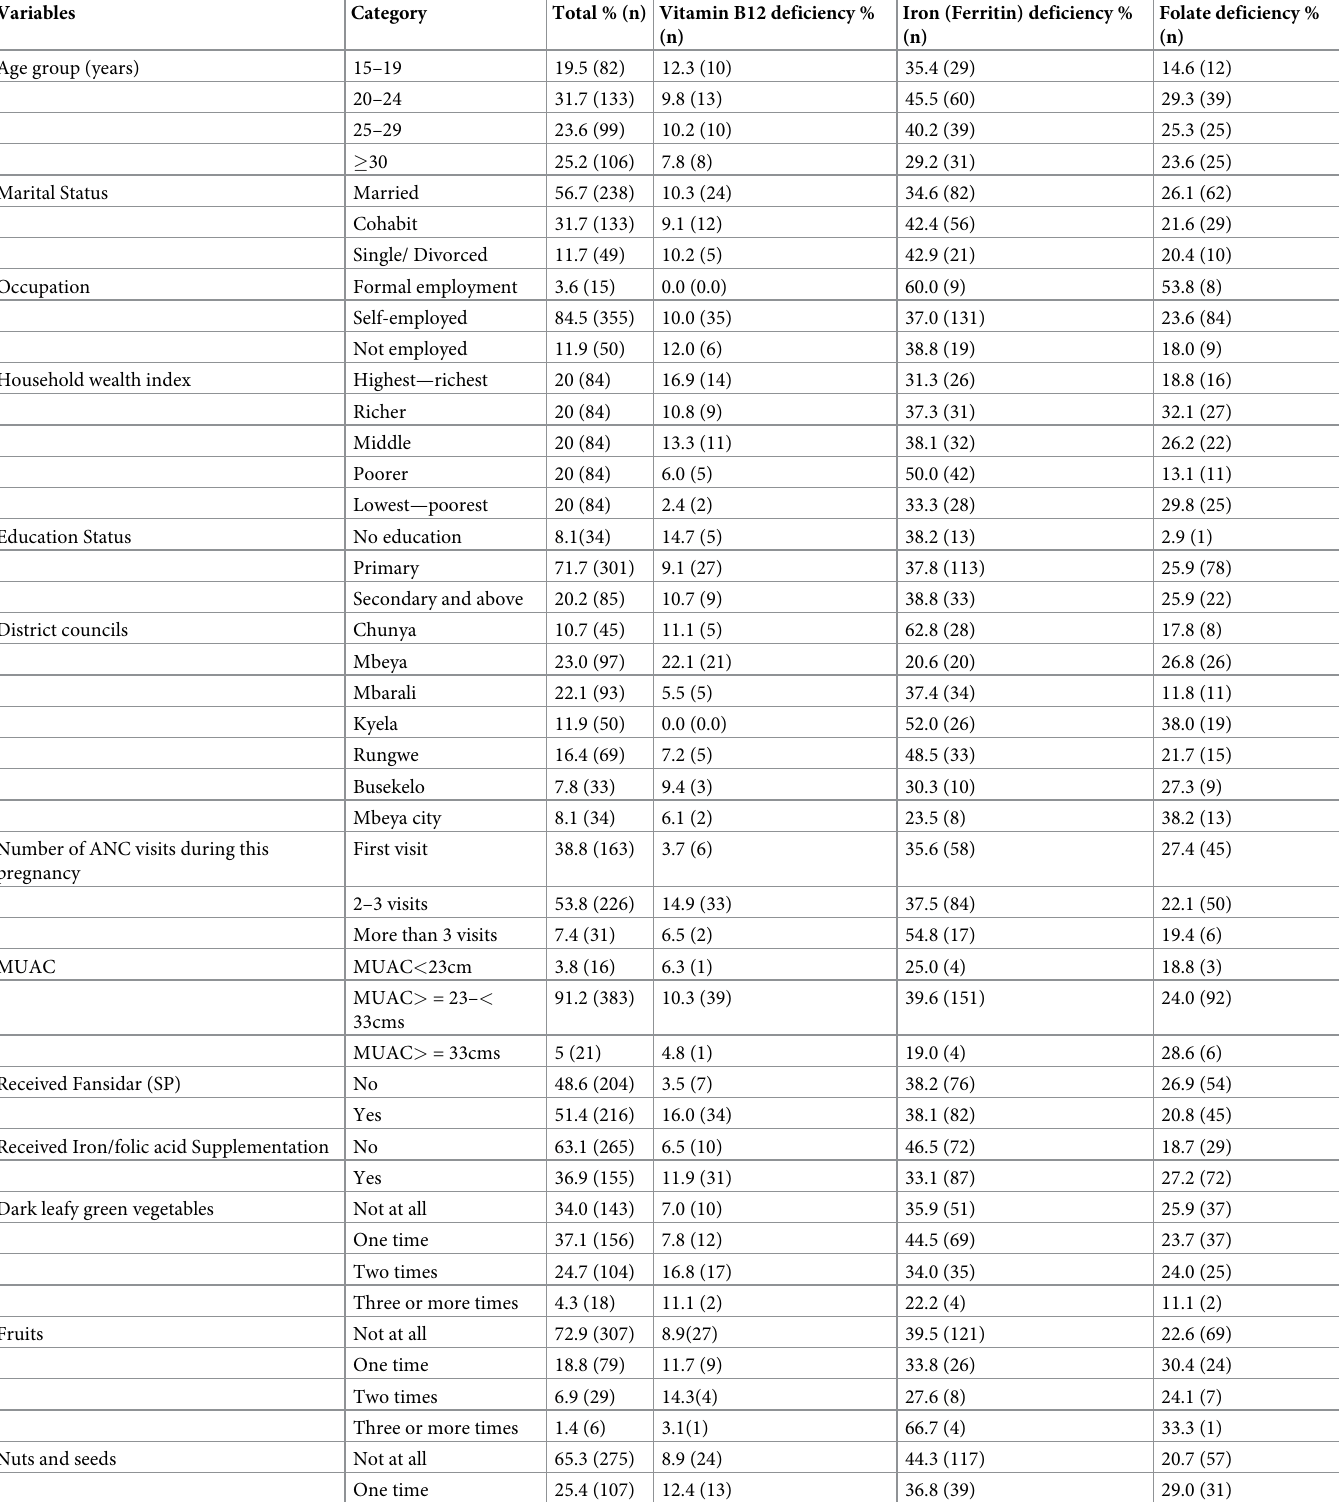
Table 2. Socio-economic, demographic, and dietary characteristics of study participants in Mbeya Tanzania (n =